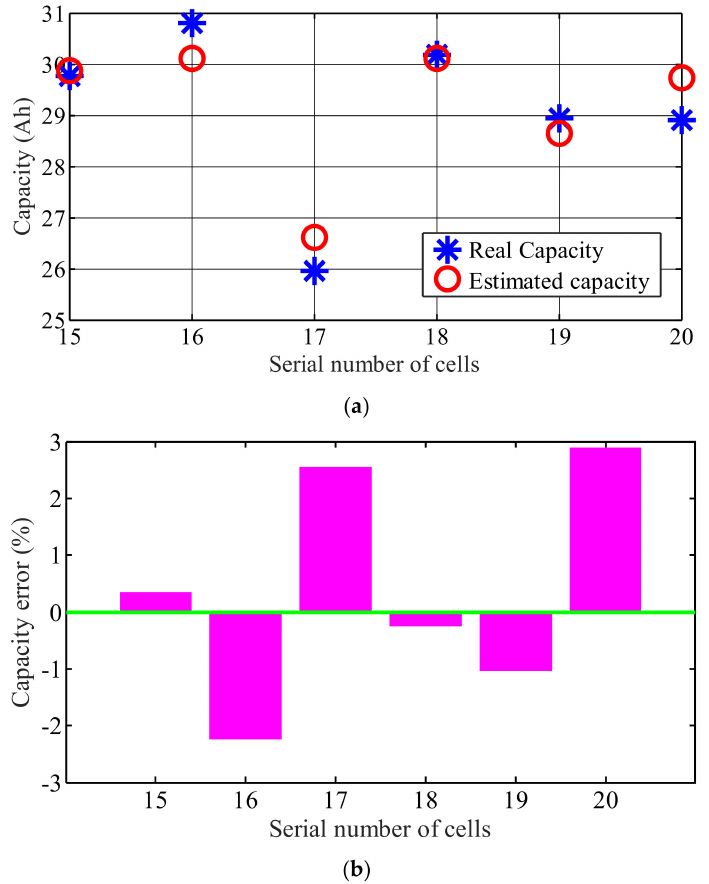
Figure 12. Estimated results: ( a ) Capacity estimation results; ( b ) estimation error.